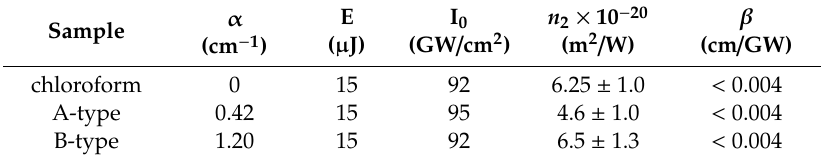
Table 1. Results of the nonlinear optical measurement of ZnO particles in chloroform at 532 nm.